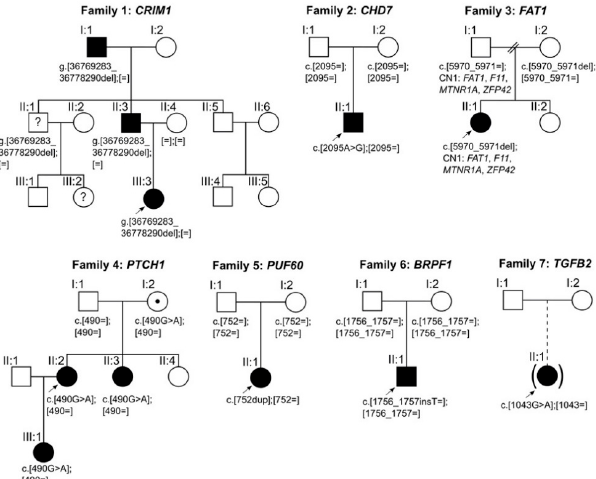
Figure 1. Pedigrees and segregation of potentially disease-causing variants identified in families 1–7. Squares indicate males; circles indicate females; filled symbols indicate affected individuals; symbols filled with a dot indicate asymptomatic carriers; symbols filled with a question mark indicate unknown disease status; brackets around symbols with a dashed offspring line indicate individuals adopted into the family; arrows indicate index patients. The putative disease-causing variants in families 2, 5, and 6 occurred de novo.